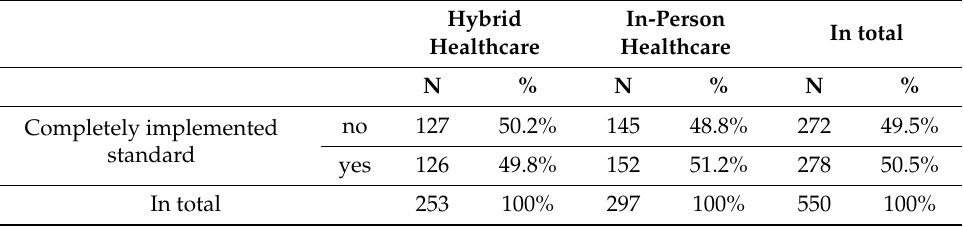
Table 4. Characteristics of prenatal care standard implementation in hybrid and in-person healthcare groups.